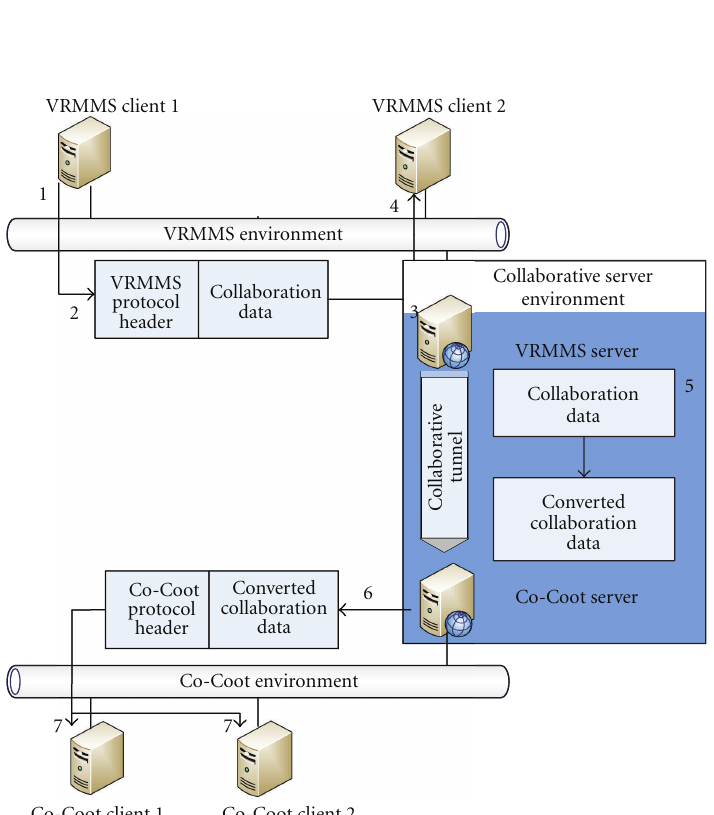
Figure 1: System overview.